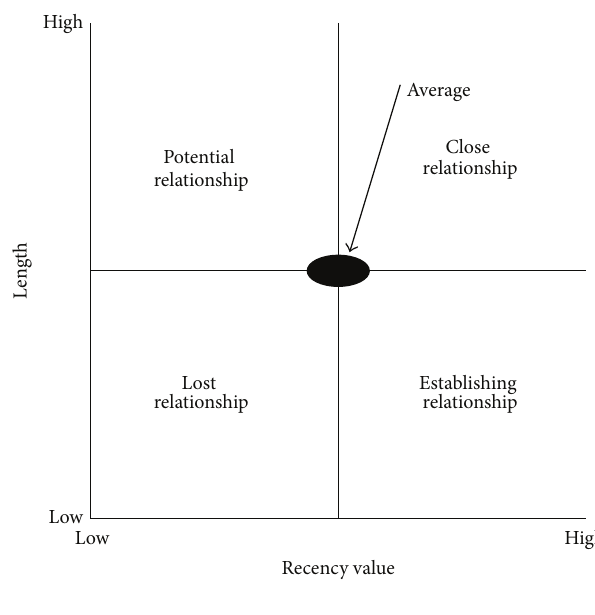
Figure 1: The customer value matrix. Figure 2: Customer relationship matrix.